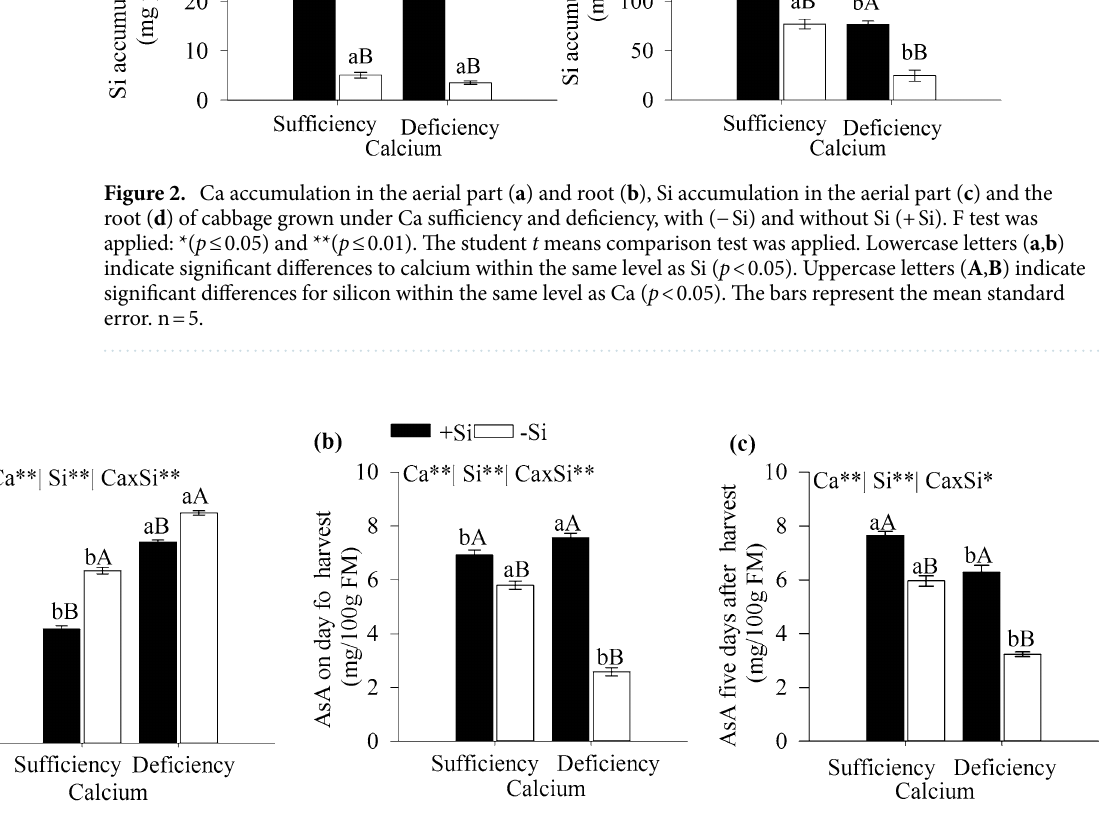
ever, the added Si increased the leaf firmness index in plants grown under Ca deficiency.